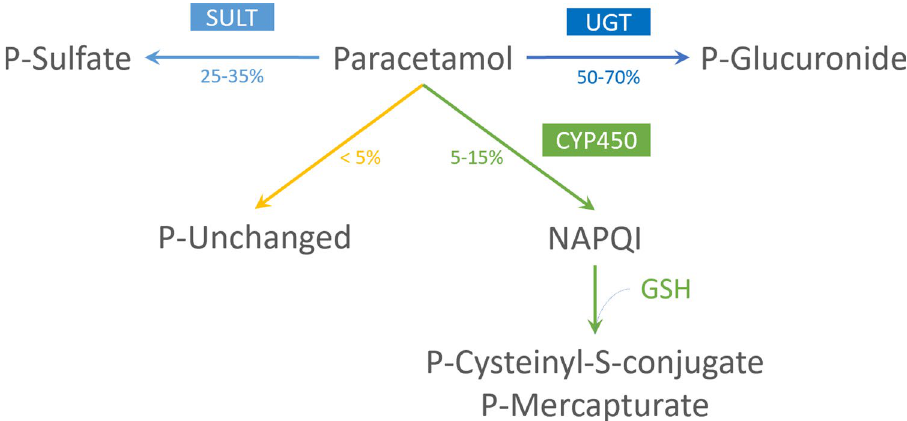
Figure 1. Paracetamol metabolism overview. P paracetamol, SULT sulfotransferase, UGT uridine 5 ′ -diphosphoglucuronosyltransferase, CYP450 cytochrome P450, GSH glutathione, NAPQI N -acetyl- p - benzoquinone